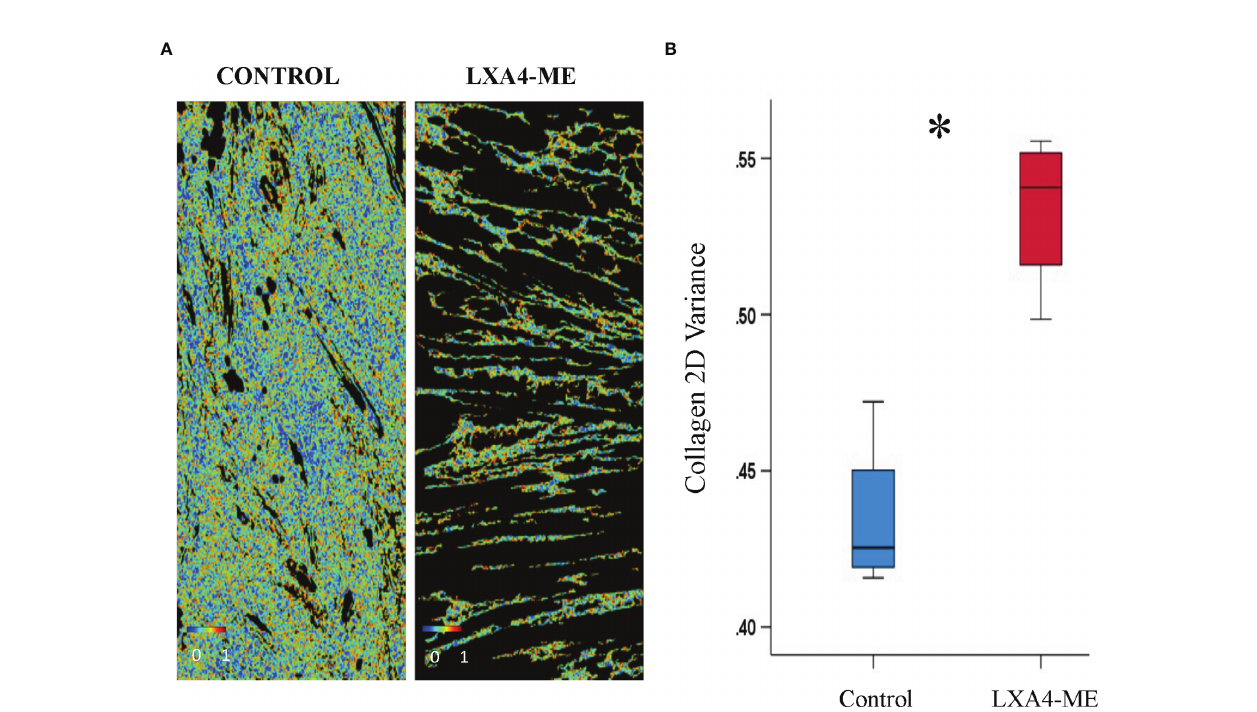
FIGURE 6 | Automated quanti fi cation of 2D directional variance (orientation) of collagen fi bers of JPEG images of representative tissue specimens stained with Masson ’ s Trichrome captured at 200x magni fi cation. (A) Topical treatment with PBS in control animals resulted in reduced 2D directional variance (median=0.42, 25 th ; 75 th percentile=0.42, 0.44) compared to treatment with LXA 4 -ME (median=0.54, 25 th ; 75 th percentile=0.52, 0.55) (B) (*P < 0.05, Mann-Whitney U test; n=4 animals/group). The average of three regions per animal were used for analysis. The color bars are ranging from